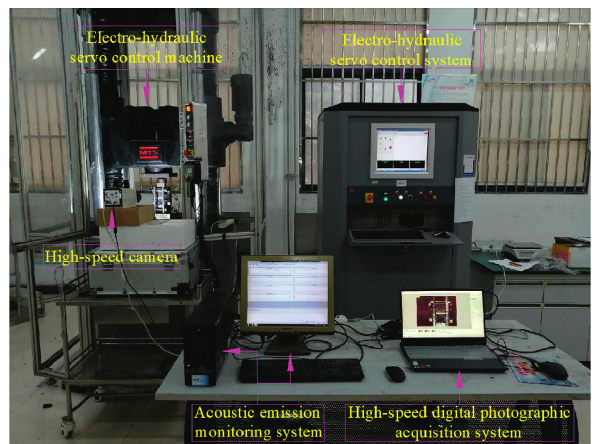
Figure 3: The experimental monitoring